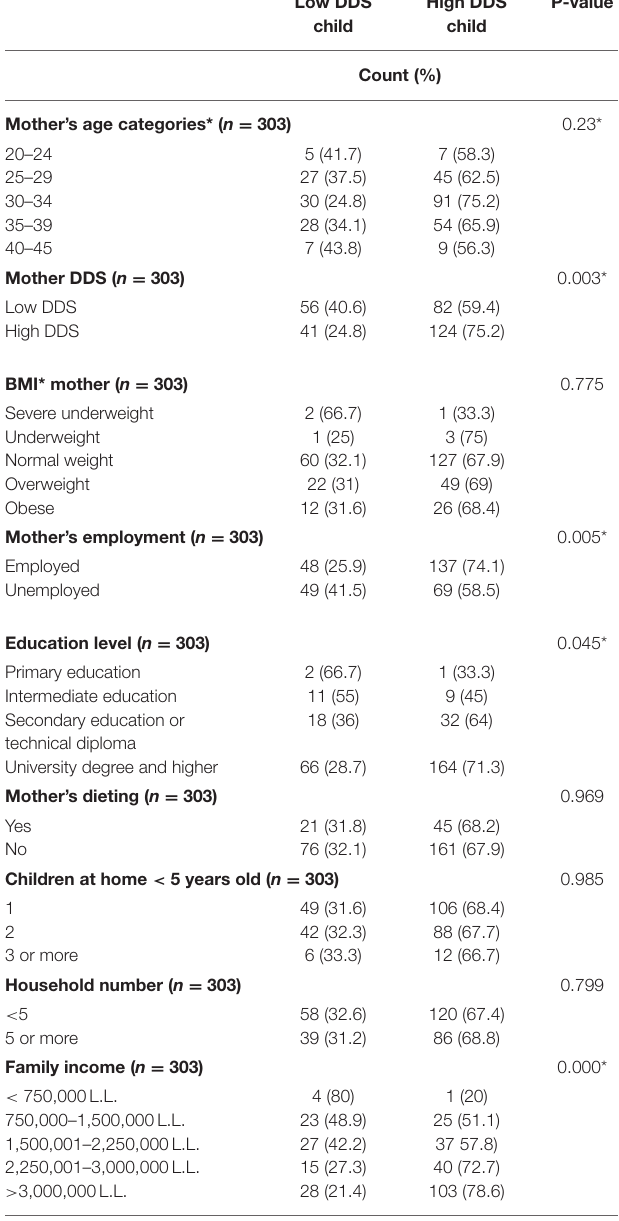
TABLE 5 | Adjusted odds ratio for child dietary diversity score according to family income and the mother’s diet diversity score. AoR* = Exp ( β ) (95%CI) P -value Low DDS High DDS child child Family